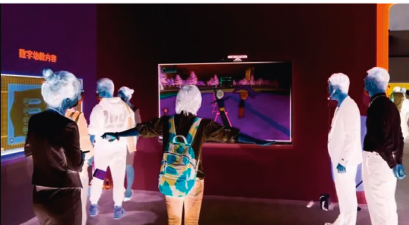
Figure 8: Recognition image of infrared interactive teaching based on artificial intelligence. Table 1: The improvement effect of the system in this paper on the teaching